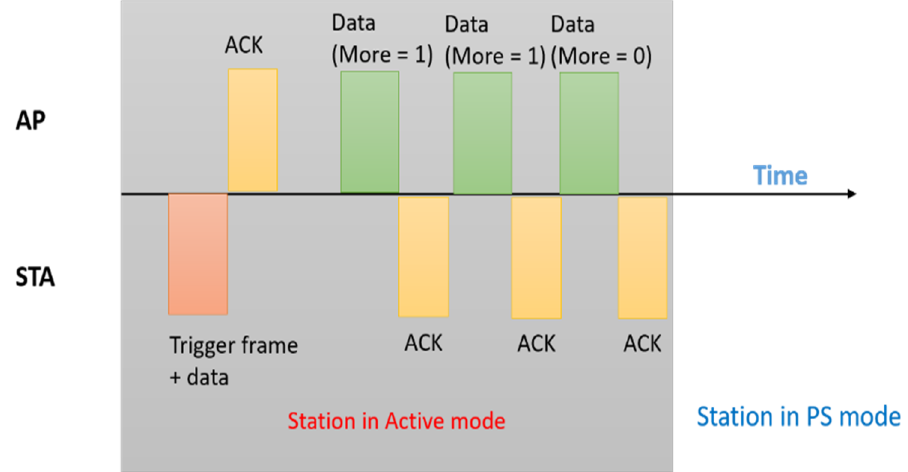
Figure 4. 802.11e PS Frame Exchange.